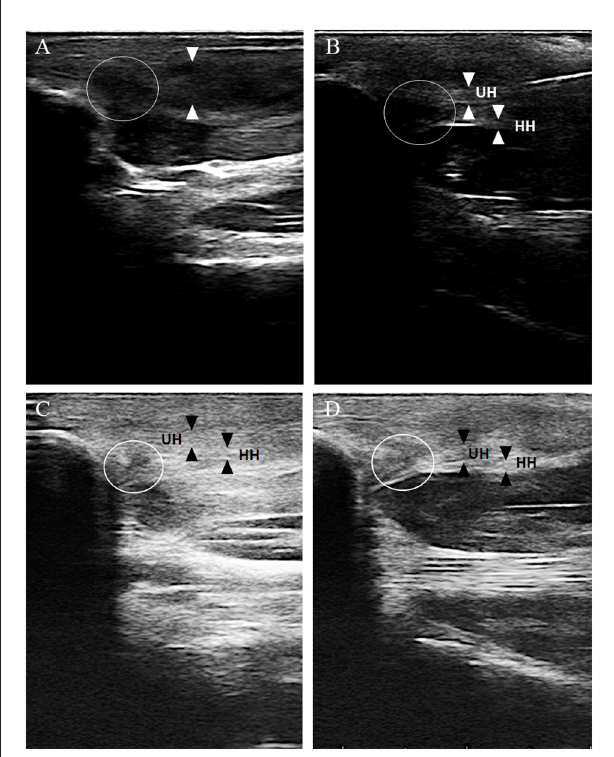
FIGURE2 The ultrasonographic evolution of the healing process at different time points. (A) Ultrasonographic evaluation at T0, longitudinal scan. The ulnar and the humeral head of the right FCU tendon (between white arrowhead) can not be distinguished and shows ES 3 and FAS 3 ( < 25% parallel fiber bundles) at its insertional portion on the accessory carpal bone. A hypoechoic area with complete loss of fiber alignment is detected (white circle). (B) Ultrasonographic evaluation at T1, longitudinal scan. The ulnar (UH) and the humeral (HH) head of the right FCU tendon show at its insertional portion on the accessory carpal bone an ES 2 and a FAS 2 with parallel fiber bundles between 25 and 49%. The hypoechoic area with complete loss of fiber alignment is still visible (circle) and consistent with T0. (C) Ultrasonographic evaluation at T2, longitudinal scan. The ulnar (UH) and the humeral (HH) head of the right FCU tendon show at its insertional portion on the accessory carpal bone an ES 1 and a FAS 2 with parallel fiber bundles between 25 and 49%. The hypoechoic area with complete loss of fiber alignment is still visible but smaller in diameter (circle). (D) Ultrasonographic evaluation at T3, longitudinal scan. The ulnar (UH) and the humeral (HH) of the right FCU tendon show at is insertional portion on the accessory carpal bone an ES 1 and a FAS 1 with parallel fiber bundles between 50 and 75%. The hypoechoic area with complete loss of fiber alignment is still visible and consistent with T2 (white circle).